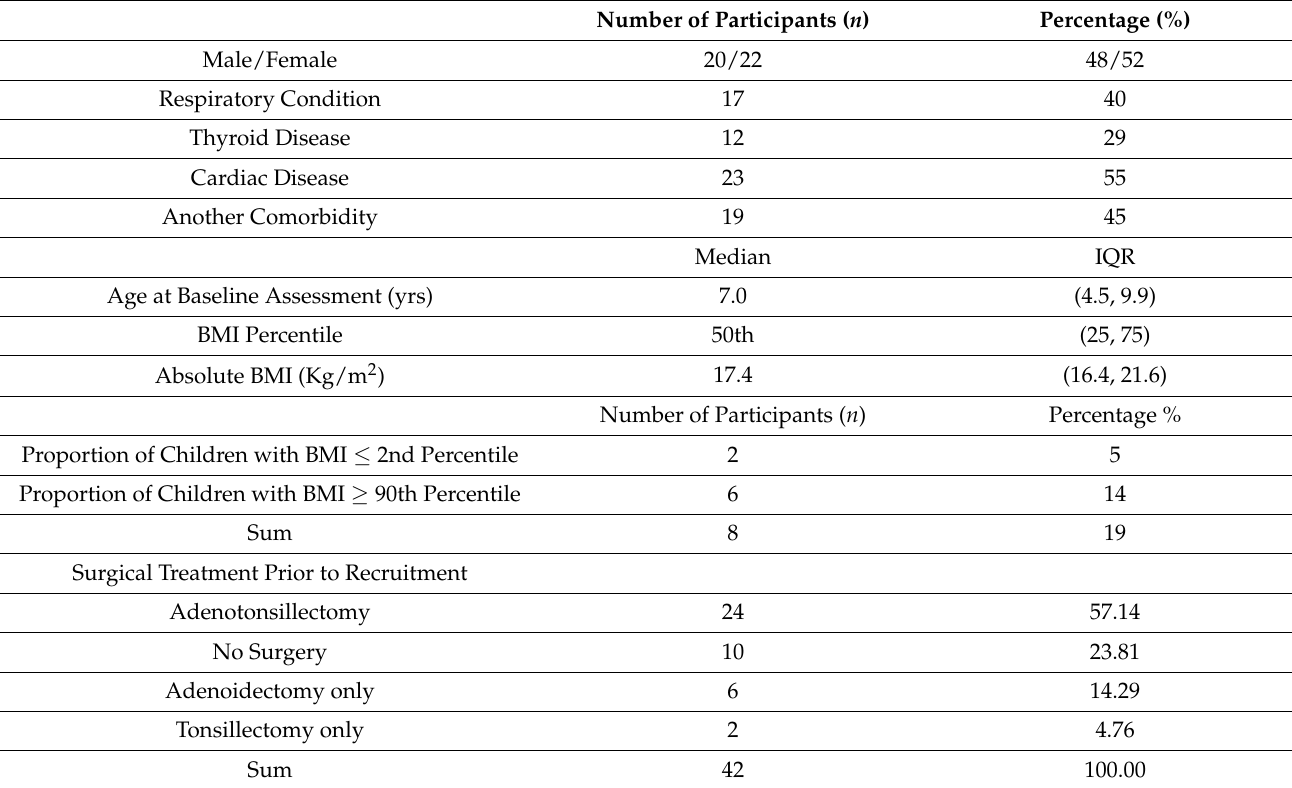
Table 1. Demographic information and summary of surgical treatment prior to